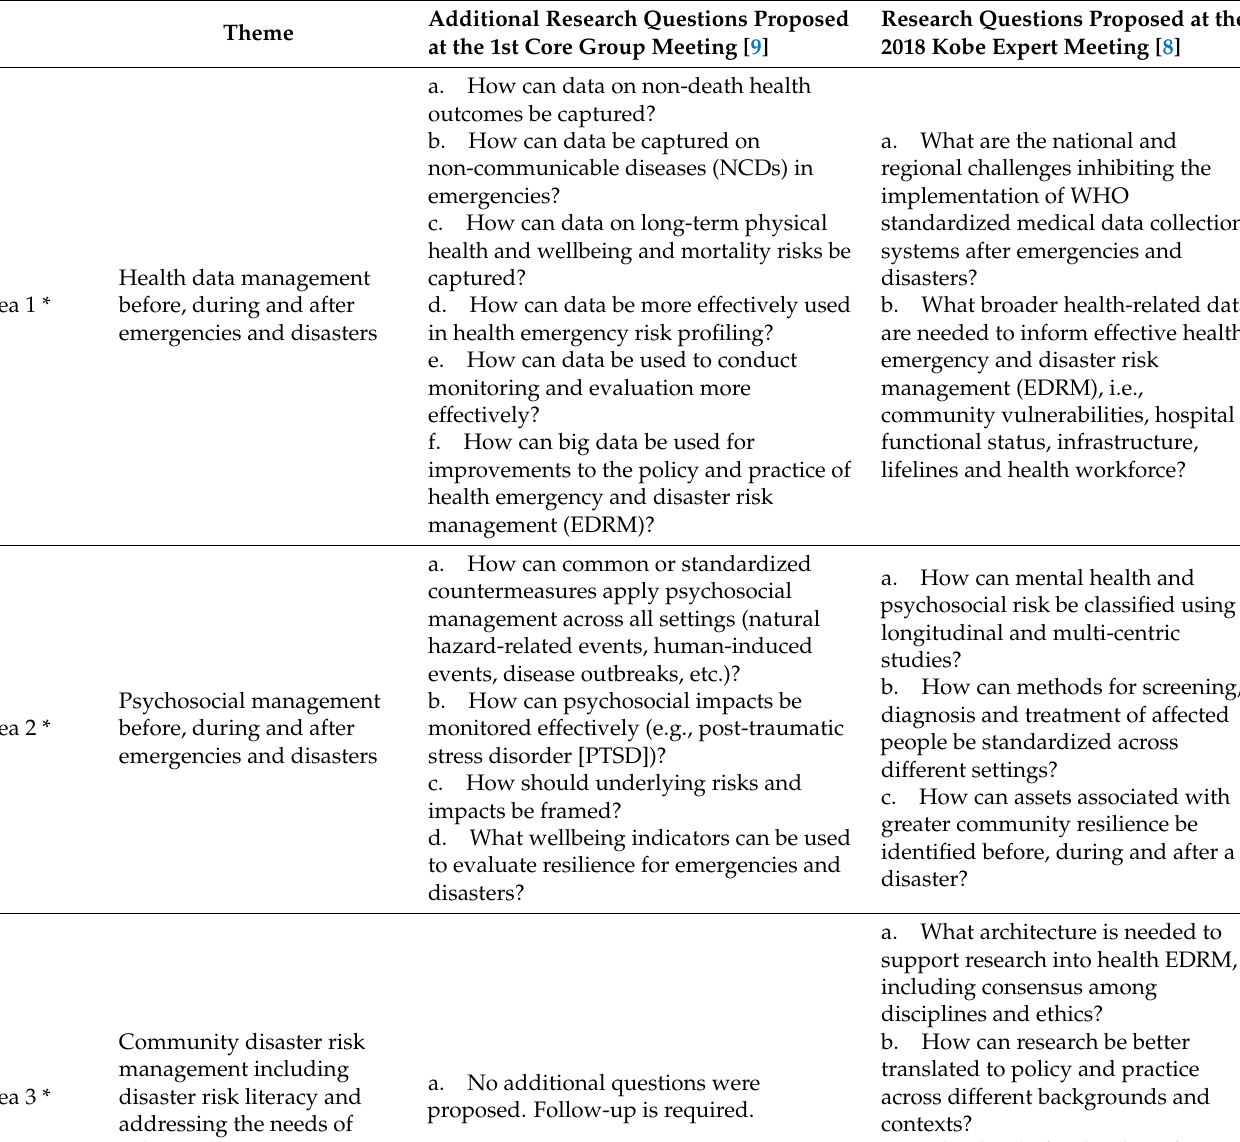
Table 1. Preliminary research themes and questions (WHO Centre for Health Development,